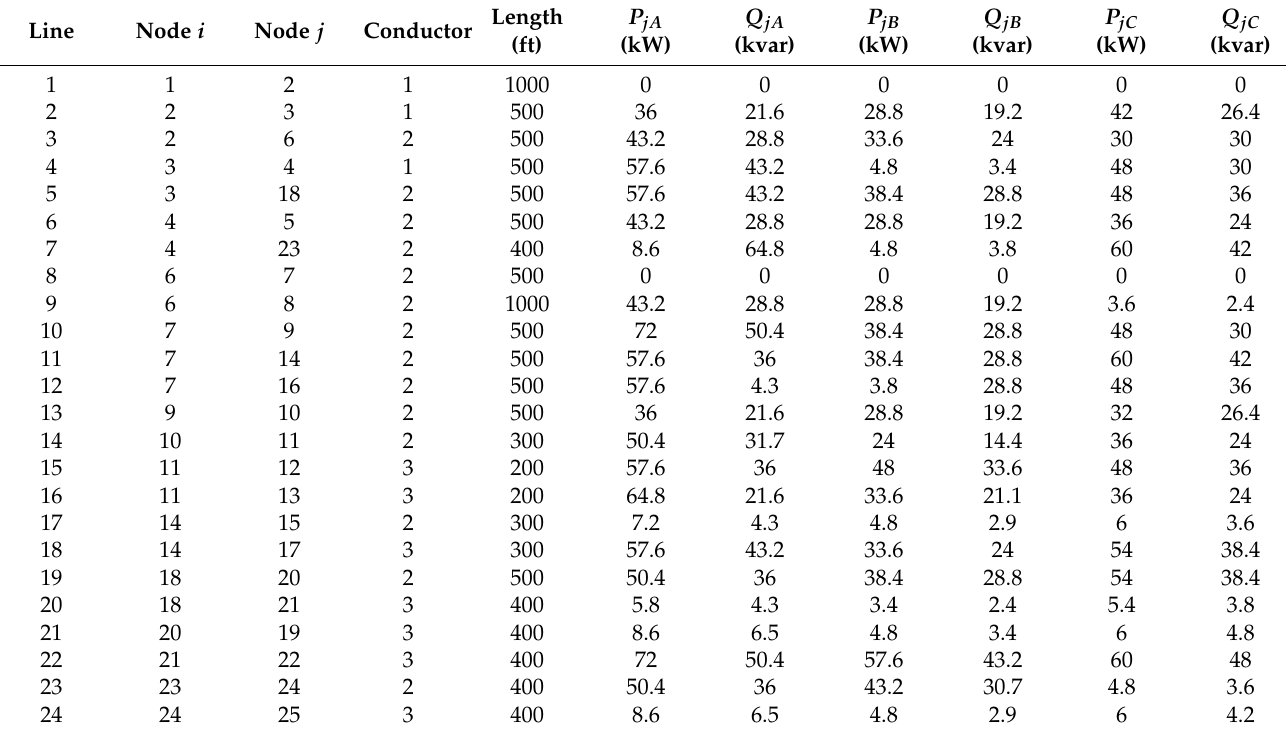
Table A3. Loads and lines parameters of the 25-node test system.